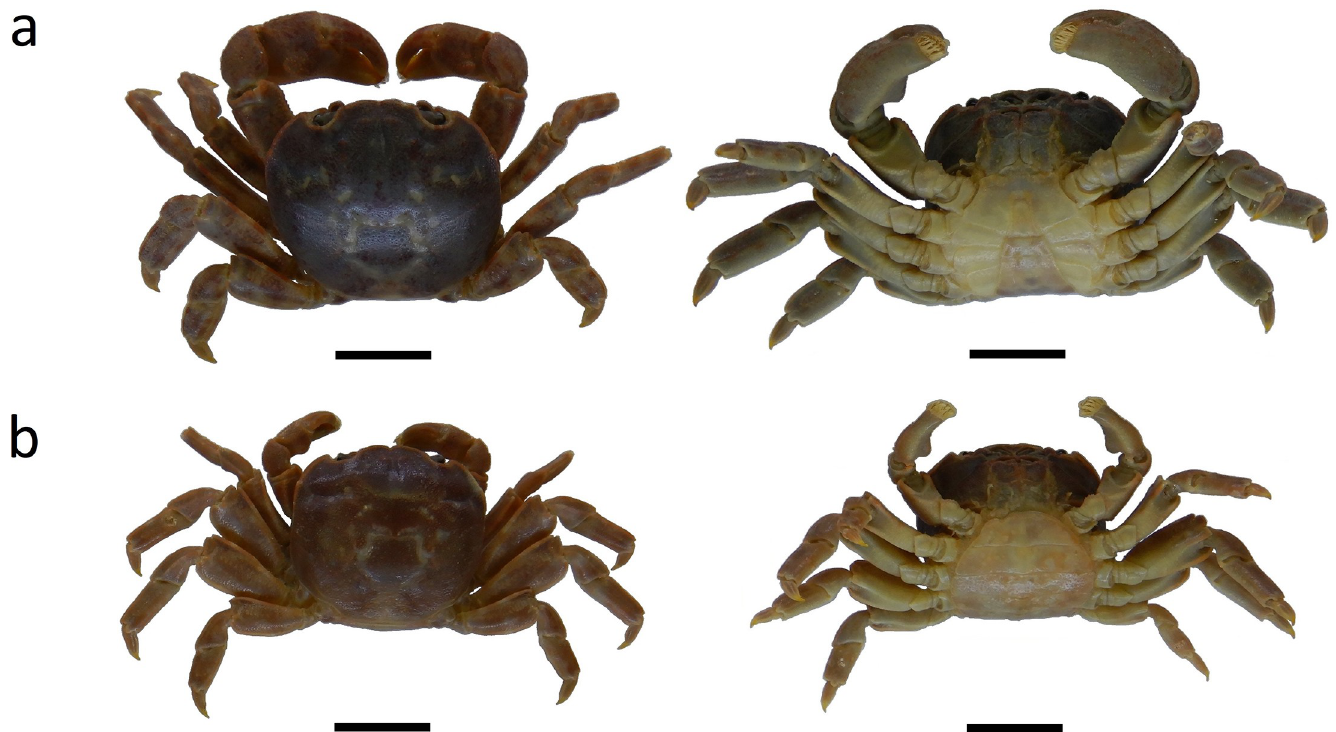
Fig 1. Xenograpsus testudinatus collected from the toxic shallow hydrothermal vent area in Kueishan Island. Male (a) and female (b) (left: dorsal view and right: ventral view). The scale bar represents 10 mm.